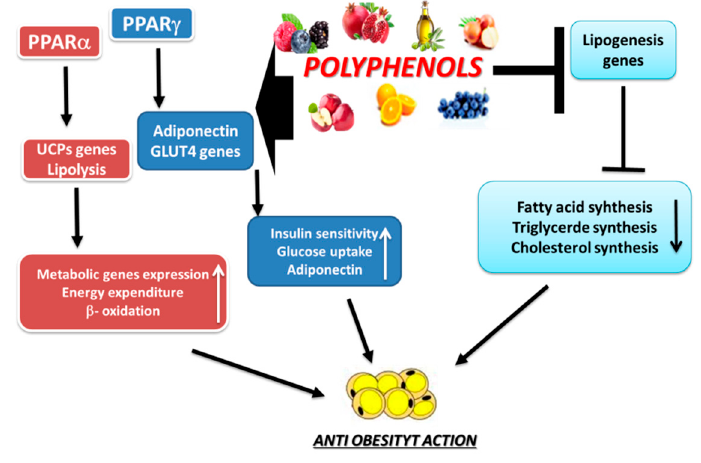
Figure 7. Some anti-obesity e ff ects of polyphenols intake .